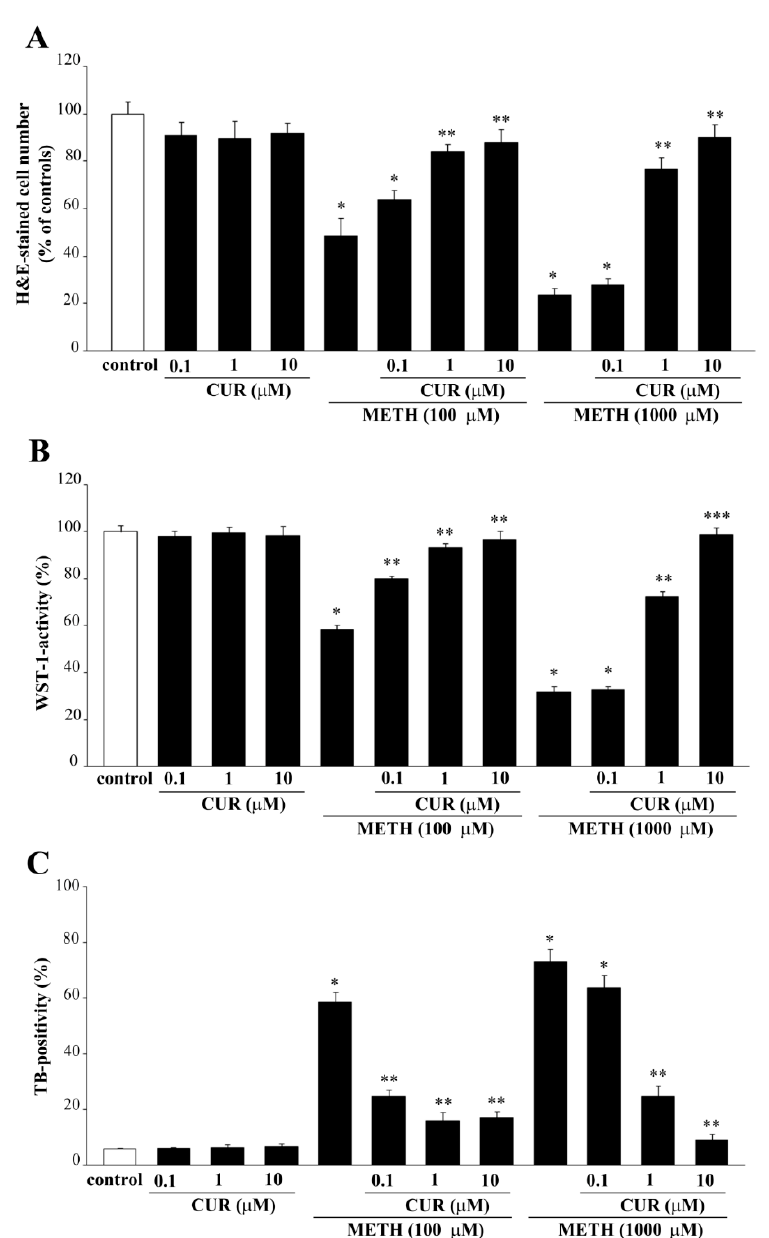
Figure 10. CUR prevents METH-induced toxicity in PC12 cells. After administration of METH, alone or in combination with CUR for 72 h, PC12 cell survival was assessed through ( A ) H&E staining, ( B ) WST-1 assay and ( C ) TB staining. * p ≤ 0.05 compared with control; ** p ≤ 0.05 compared with METH; *** p ≤ 0.05 compared with METH 1000 μ M + CUR 1 μ M.